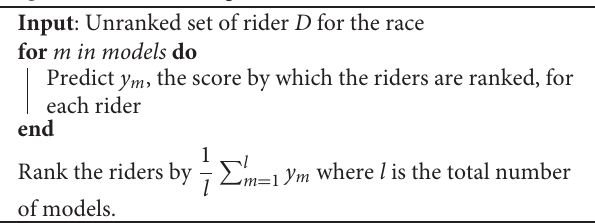
Algorithm 2: Predicting rank with trained